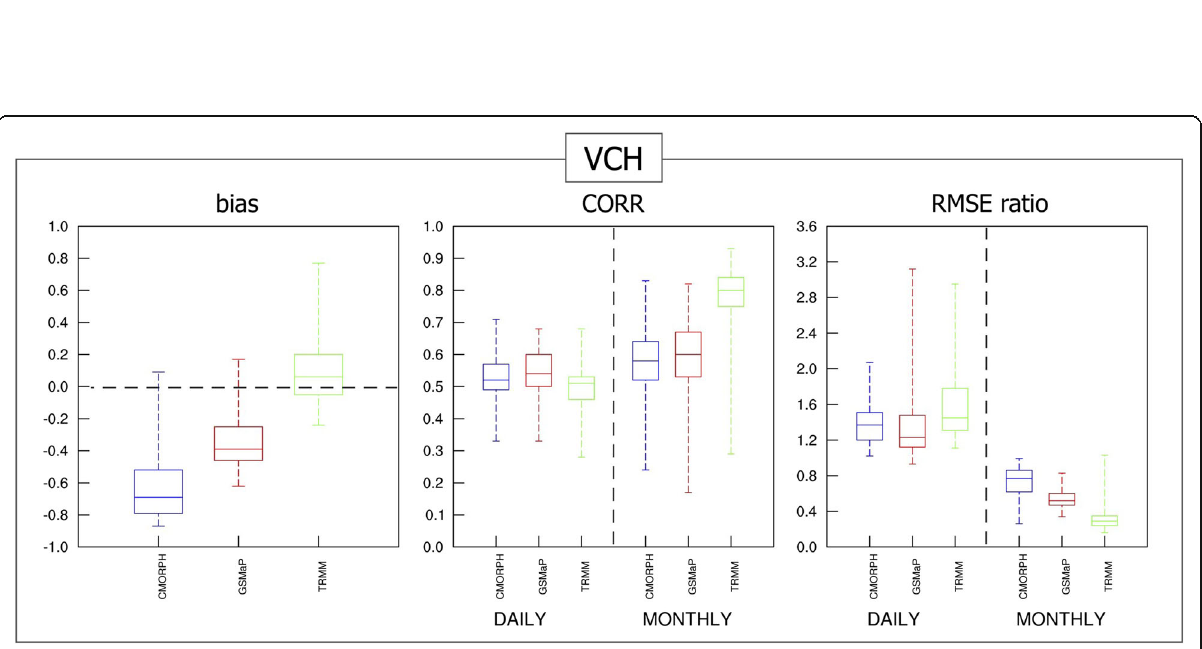
Fig. 6 Boxplots for bias, CORR, and RMSE ratio for 88 grid point values over the VCH for comparison of three SPDs (CMORPH, GSMaP, and TRMM) with monthly VnGP rainfall, for MJJA in 2001 – 2010. Boxplots of CORR and RMSE ratio values are shown also for daily rainfall. Sample numbers are N = 1230 for each bias value, N = 1230 for each CORR or RMSE ratio value for daily rainfall, and N = 40 for each CORR or RMSE ratio value for monthly